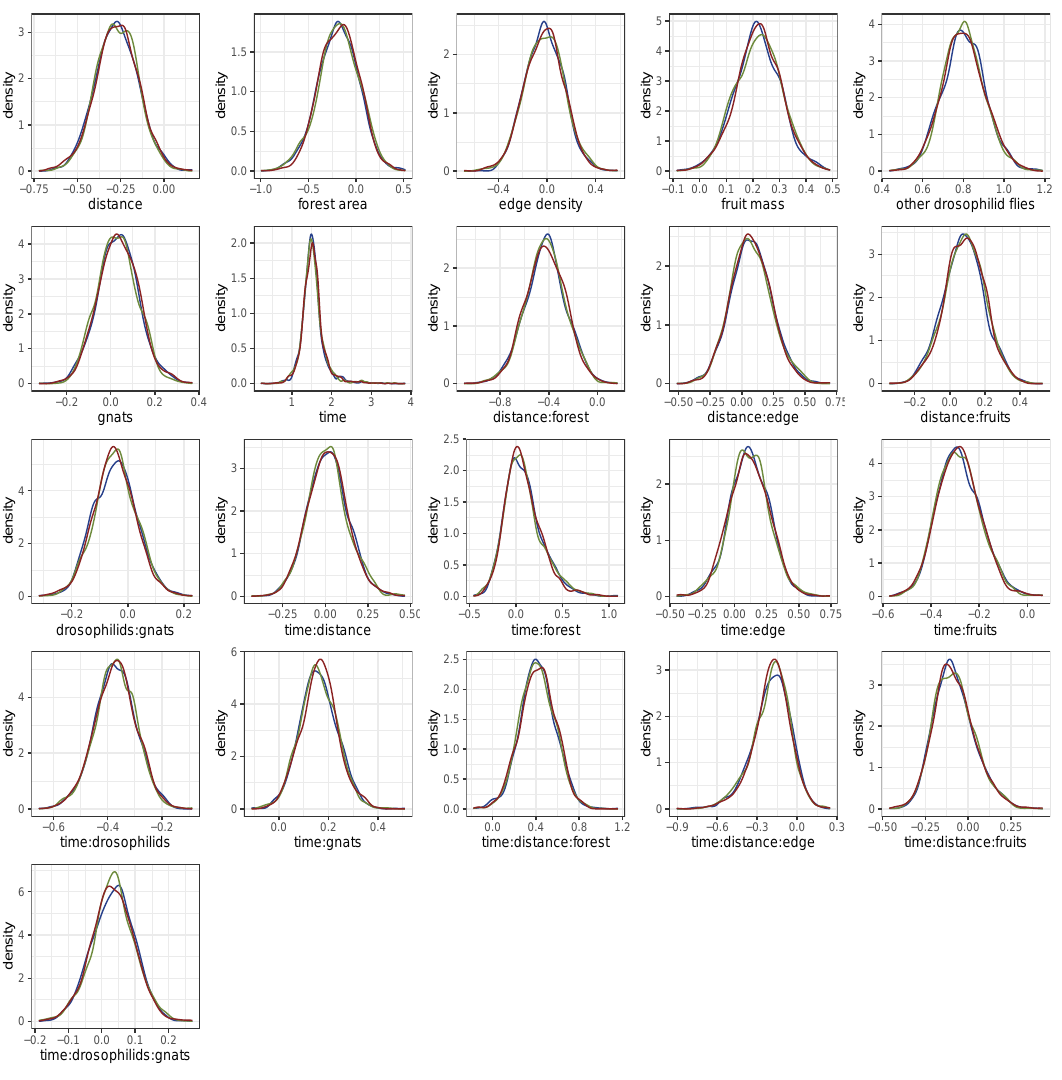
Figure A4. Density plots of posterior draws from each chain for parameters of the model variables. Please note that the variable time is represented by calendar weeks and burnins are